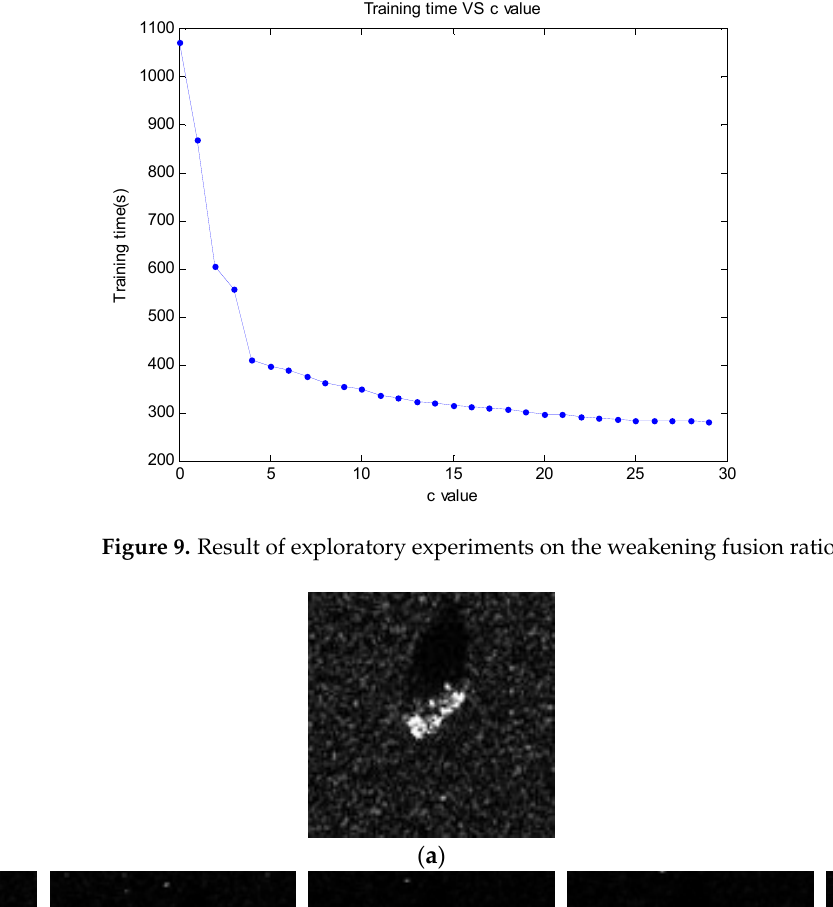
Figure 9. Result of exploratory experiments on the weakening fusion ratio.